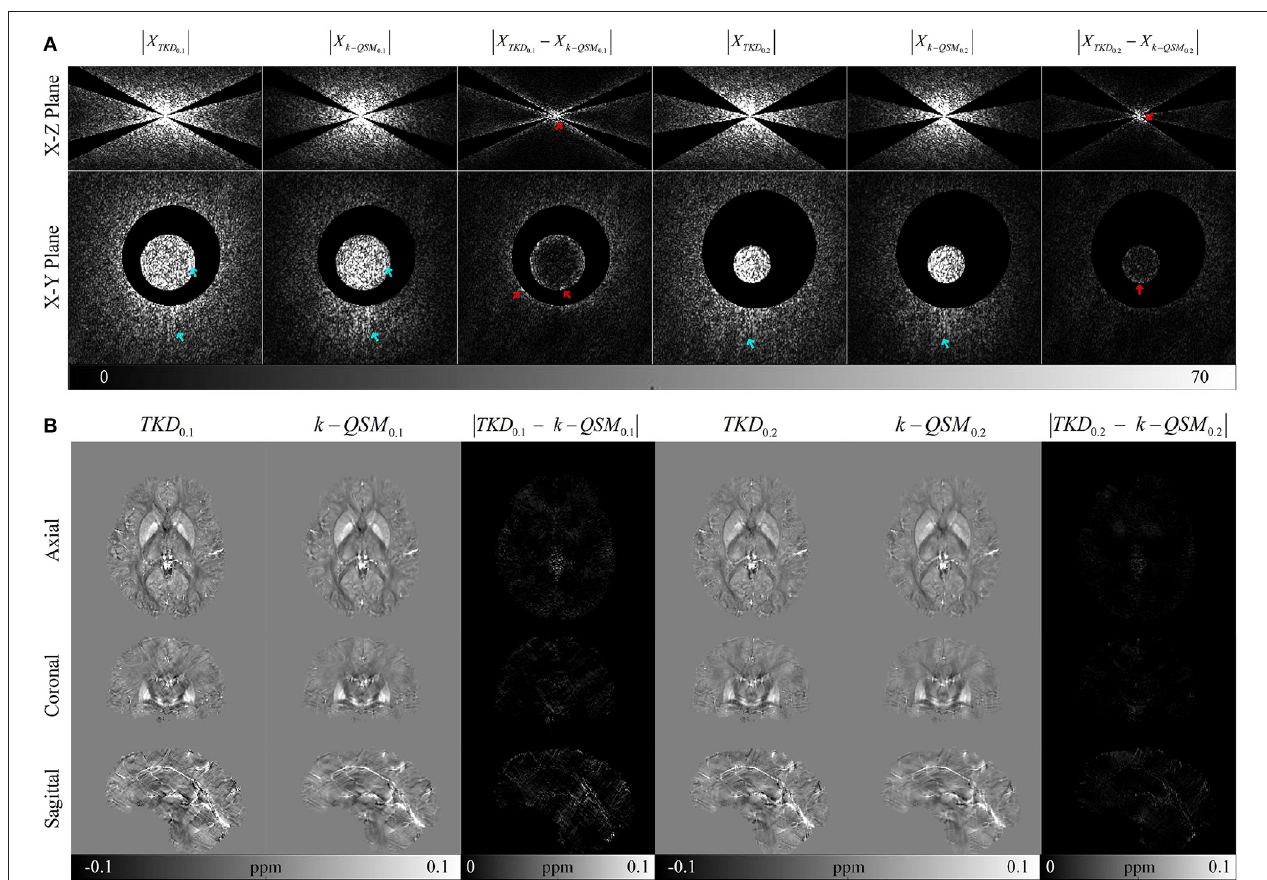
FIGURE 4 | Comparison on signals of k-QSM output and truncated k-space division (TKD) in non-ill-posed regions with error residual views. (A) The signals in the Fourier domain, with cyan arrows indicating the similarity between TKD and k-QSM, and red arrows marking the differences around the boundaries. (B) The spatial domain data of (A)